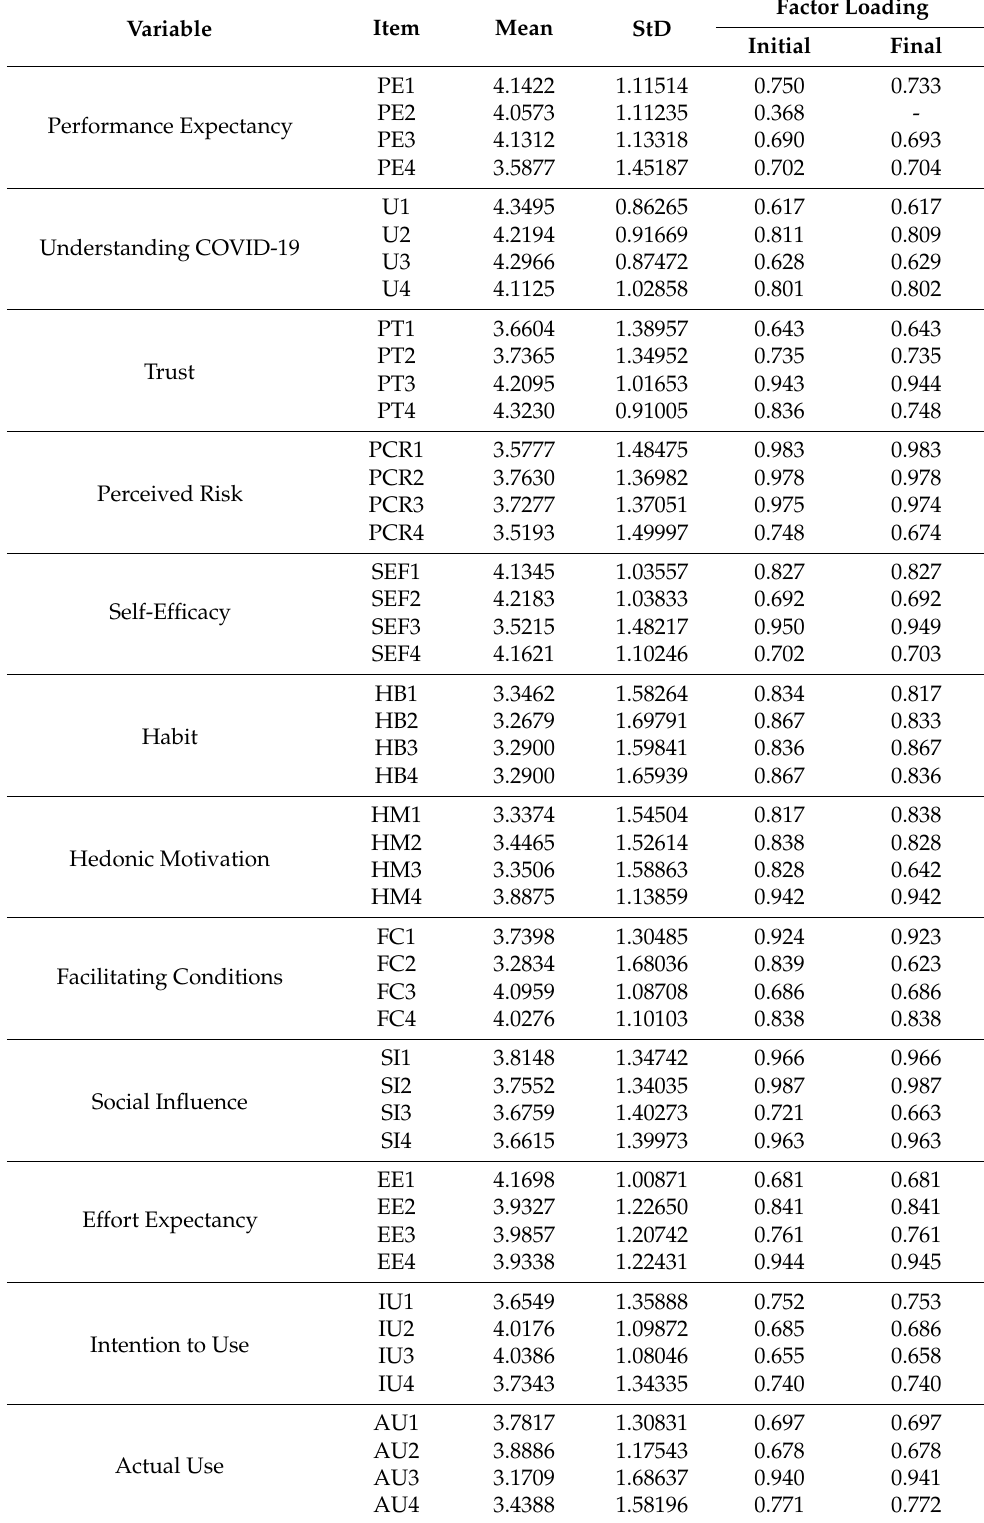
Table 3. Indicators from statistical